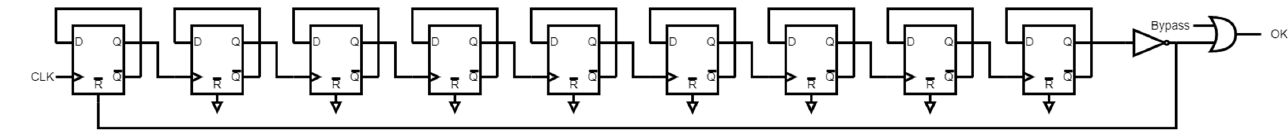
Figure 6. Simple all digital OK circuit.